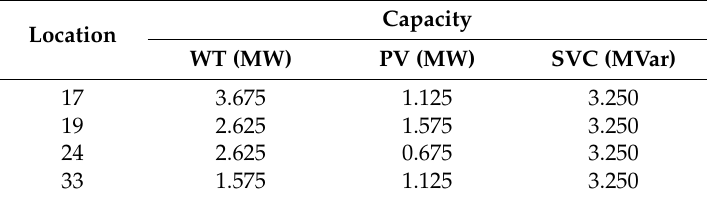
Table 1. Simulation data for WT, PV and SVC.